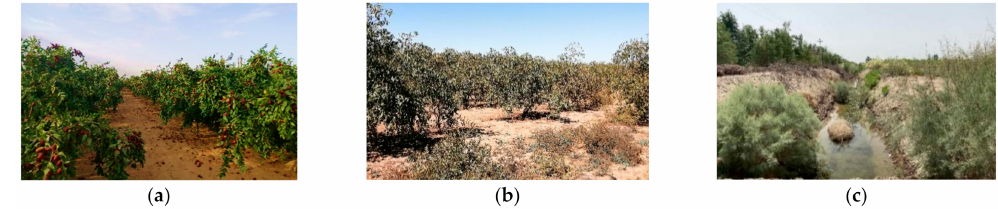
Figure 2. Three types of jujube fields: ( a ) in-production field; ( b ) abandoned field; and ( c ) alkali draining ditch.